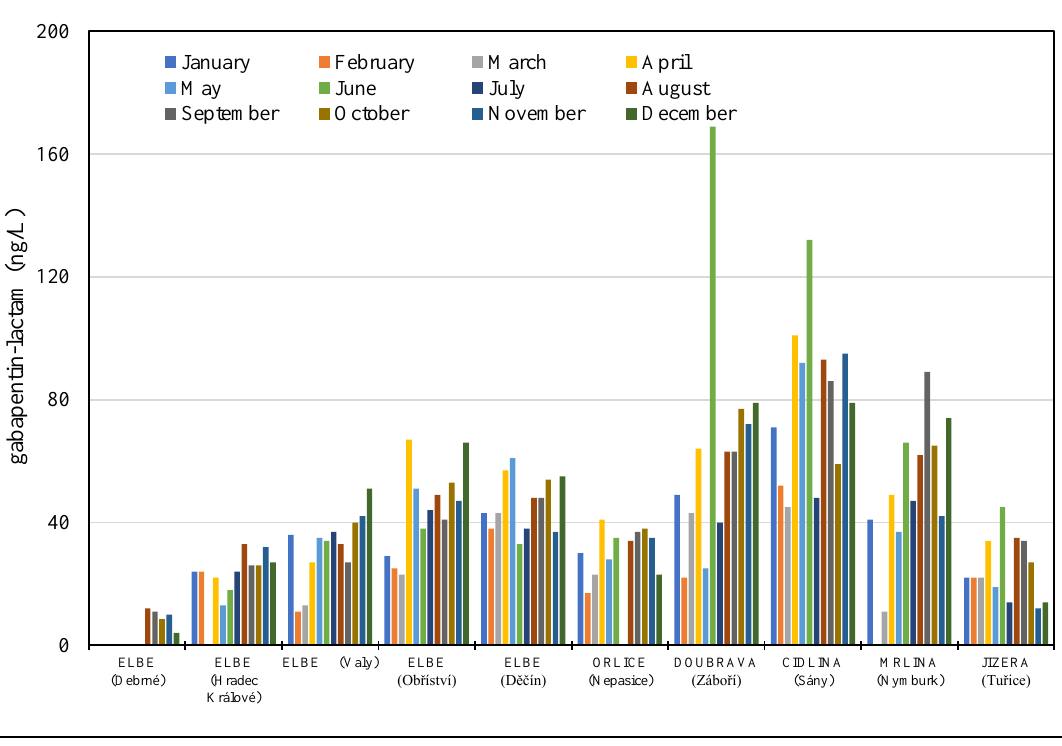
Figure 4. Residues of gabapentin-lactam in surface water of the Elbe River basin .